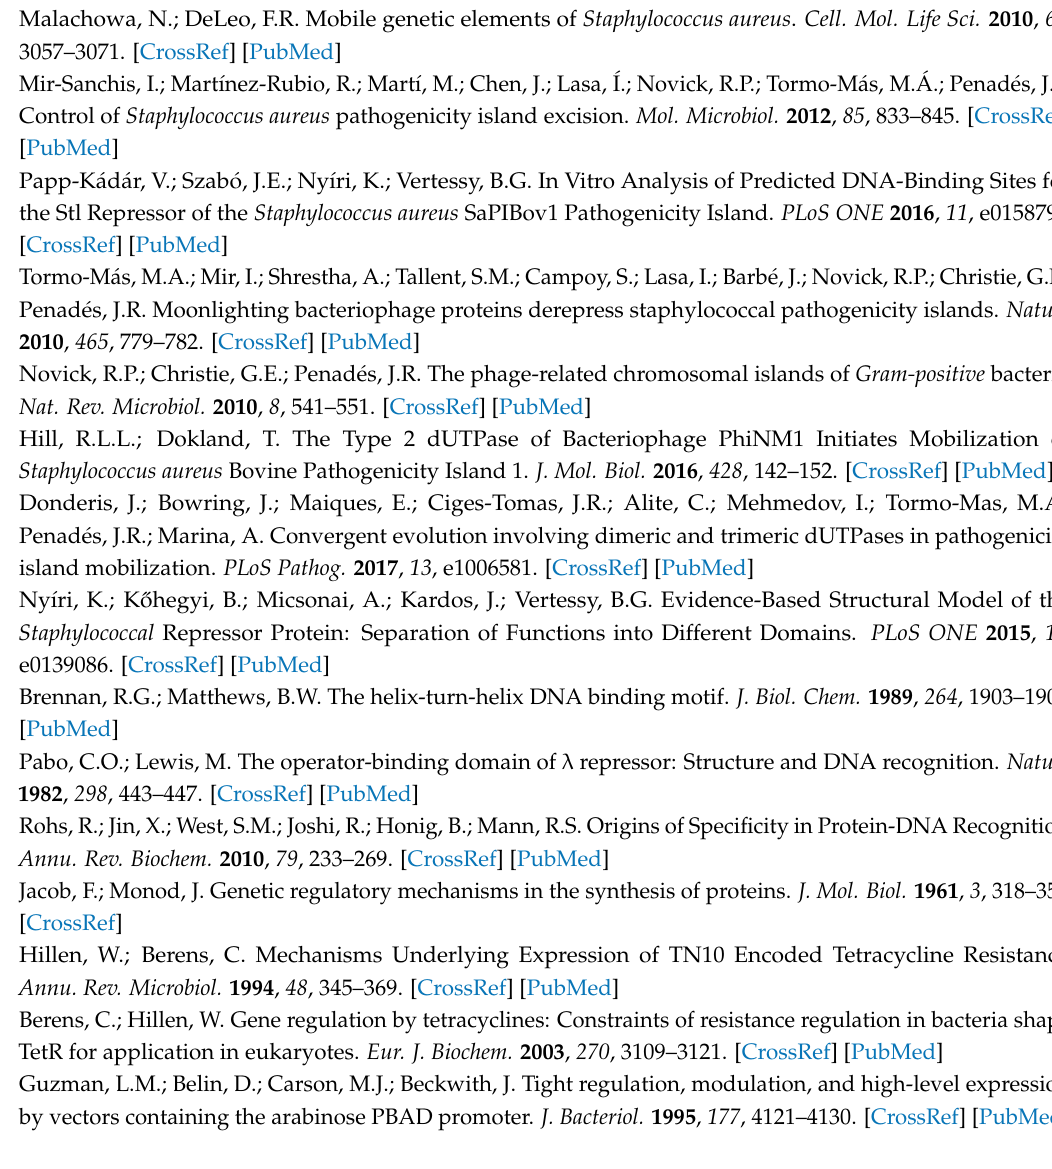
Table S1: Stl mutants identified with reduced DNA binding ability in the Stl switch system, Table S2: Oligonucleotides used in the present study, Table S3: Plasmids used in the present study. Acknowledgments: This work was supported by the National Research, Development and Innovation Office (K109486, K119493, NVKP_16-1-2016-0020 to BGV, K115993 and FK124527 to Judit T ó th), the Hungarian